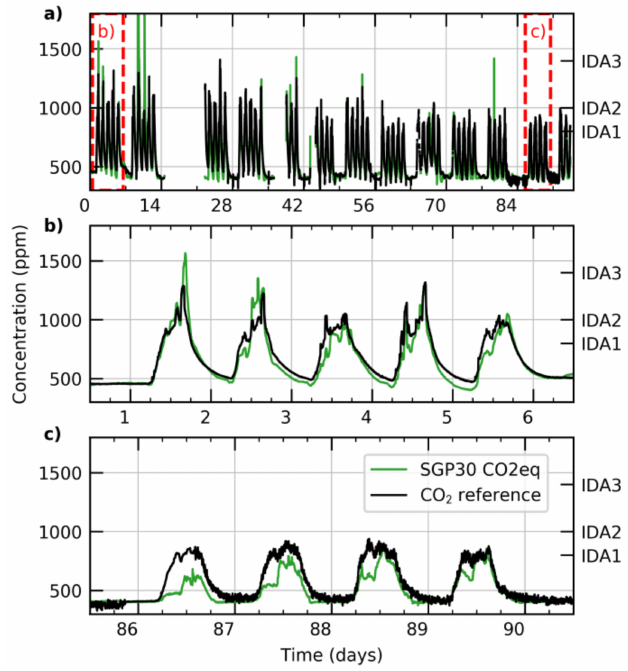
Figure 9. CO 2 data taken over about 3 months in a typical corporate meeting room ( a ). The output of the non-dispersive infrared (NDIR) CO 2 reference (black line) is compared to the output of the SGP CO2eq algorithm (green line). The two red rectangles indicate the position of the zoom-ins provided in panels ( b , c ). On the secondary y-axis the maximum values of the corresponding indoor air-quality (IDA) levels are indicated